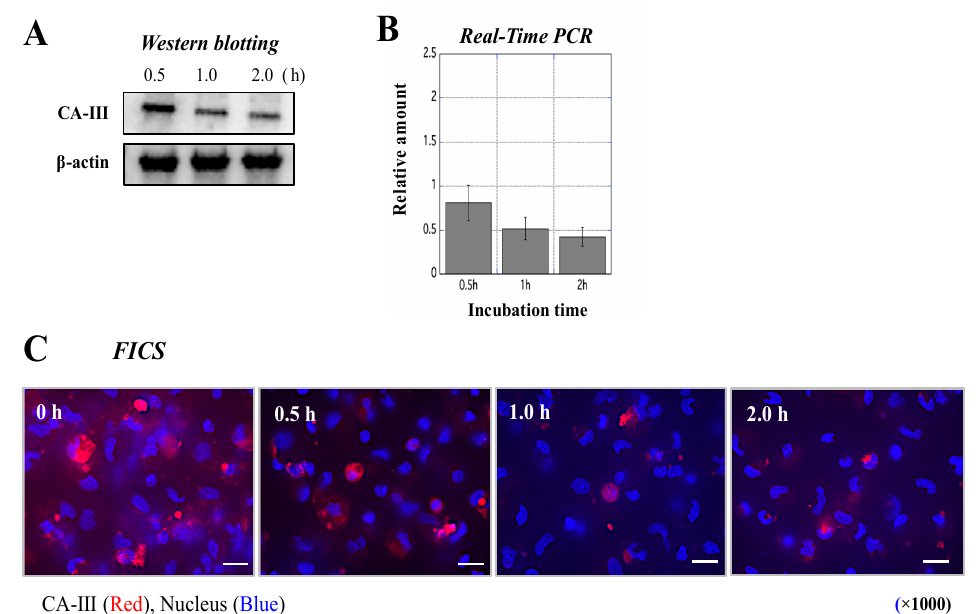
Figure 8. Measurement of CA-III expression in rat M Φ incubated with anti-CAIII Ab by western blotting, real-time PCR, and immunofluorescence. ( A) Western blotting was performed to detect CA-III in M Φ incubated with anti-CAIII Ab (Figure S5). The upper and lower panels show CA-III and β -actin (internal control) expression, respectively, in M Φ incubated with anti-CAIII Ab for 0.5, 1, and 2 h. ( B ) Real-time PCR was performed to analyze the relative amount of mRNA in M Φ incubated with anti-CAIII Ab. The X-axis indicates the incubation time (0.5, 1, and 2 h), while the Y-axis shows